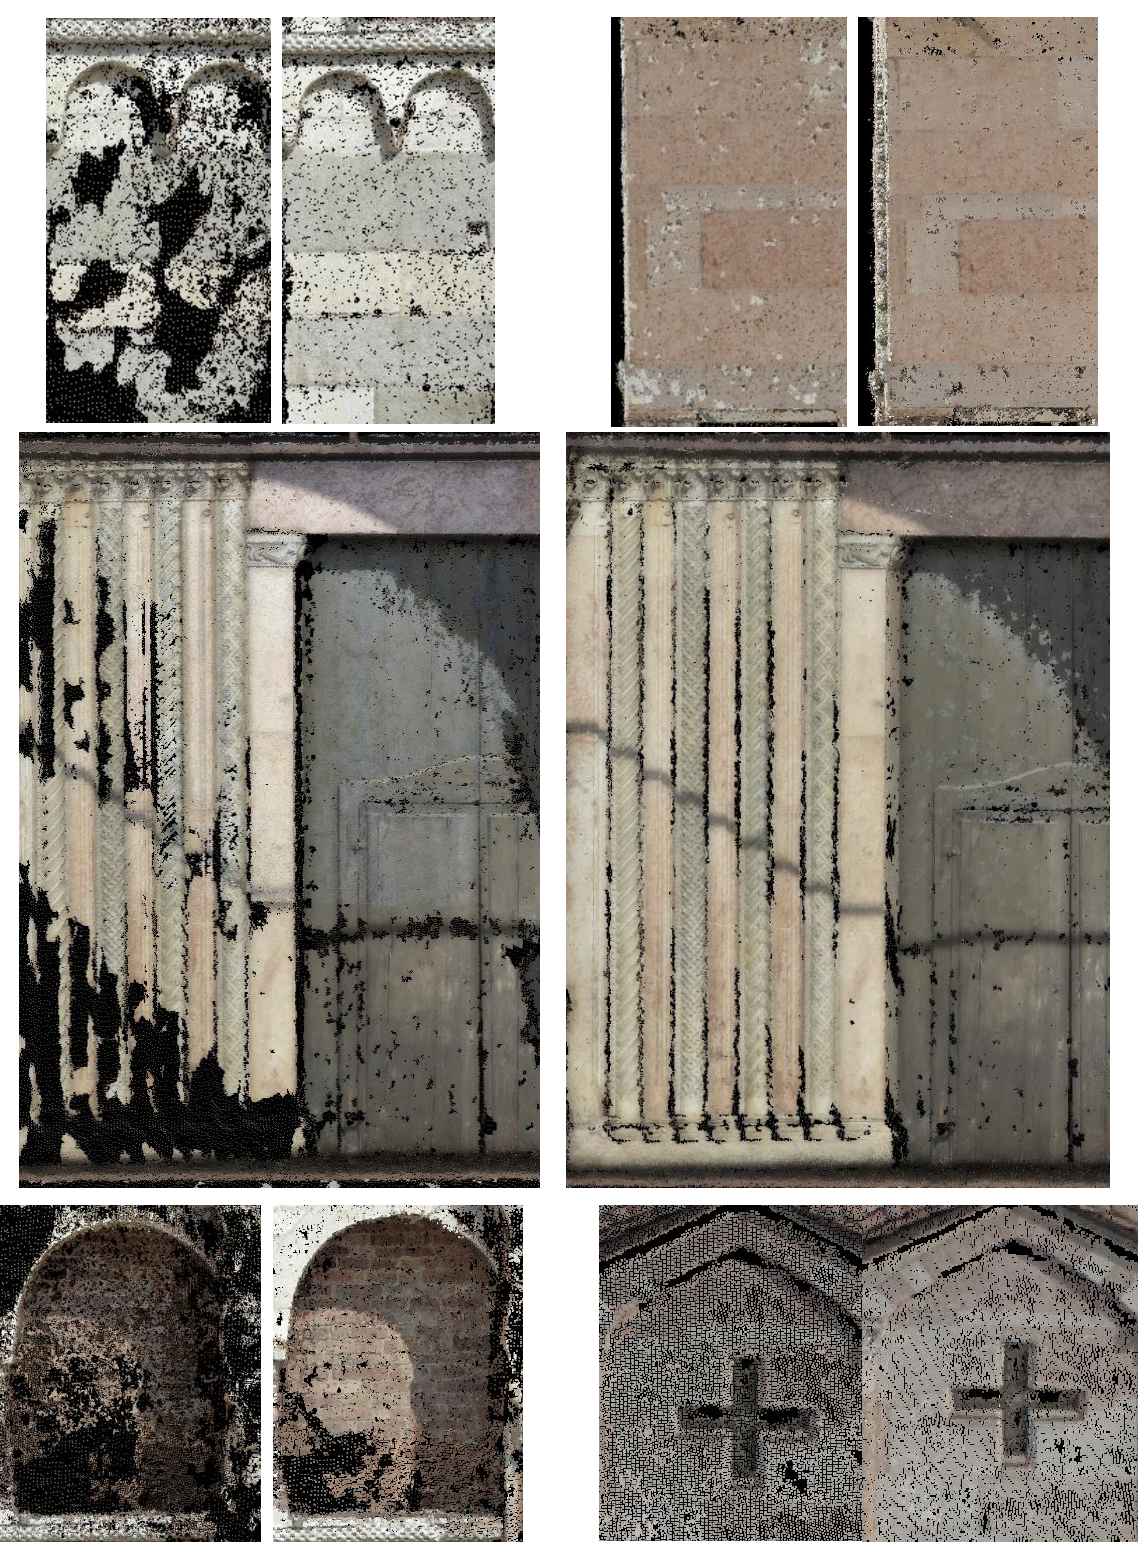
Figure 10: Qualitative evaluation of the dense point clouds derived with the standard photogrammetric pipeline (left images for each box) and the clouds derived after the proposed filtering method (right images). A visual comparison highlights clear improvements in the dense reconstruction (less holes, higher density,